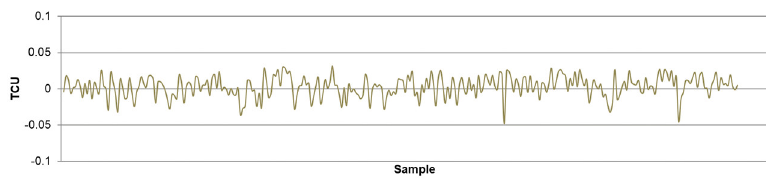
Figure A41. Prediction error of NN3 model testing dataset.